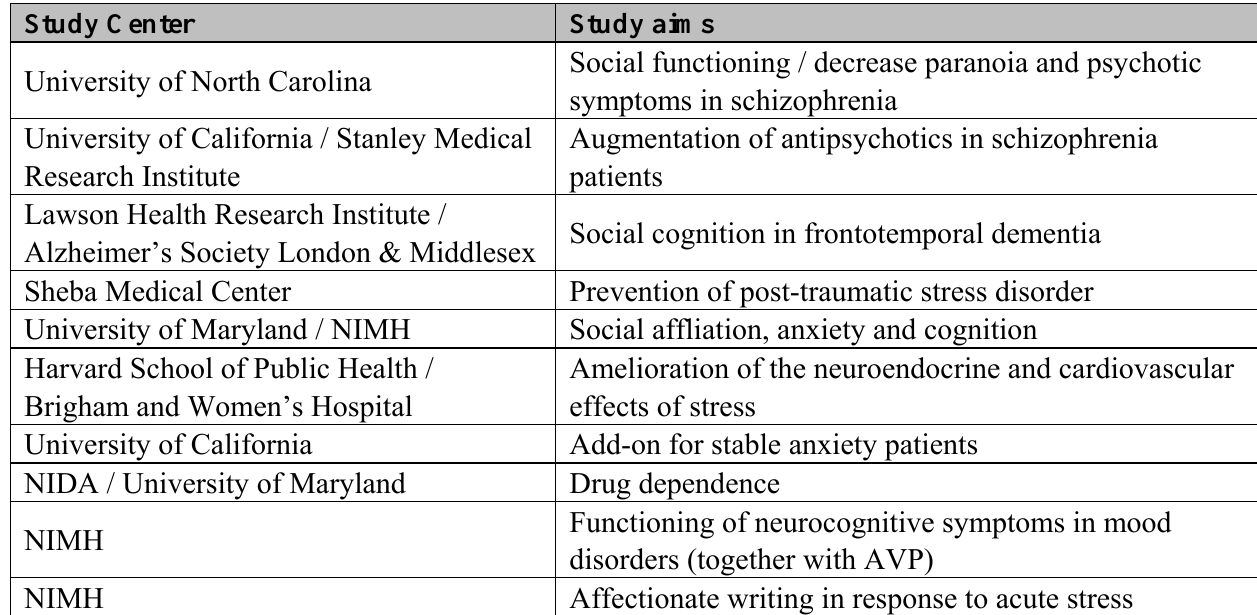
Table 1. Current drug discovery status of OXT and endophenotypes of